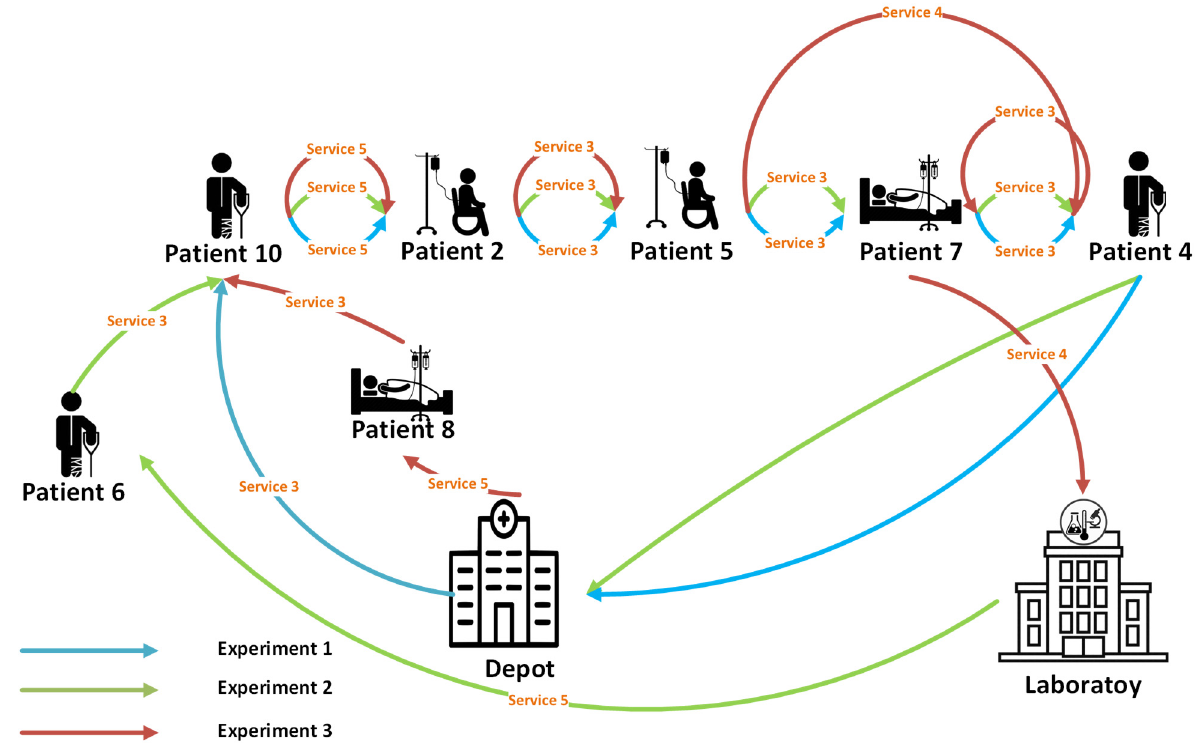
Figure 3. Different results of the experiments for the sensitivity analysis on parameter R .